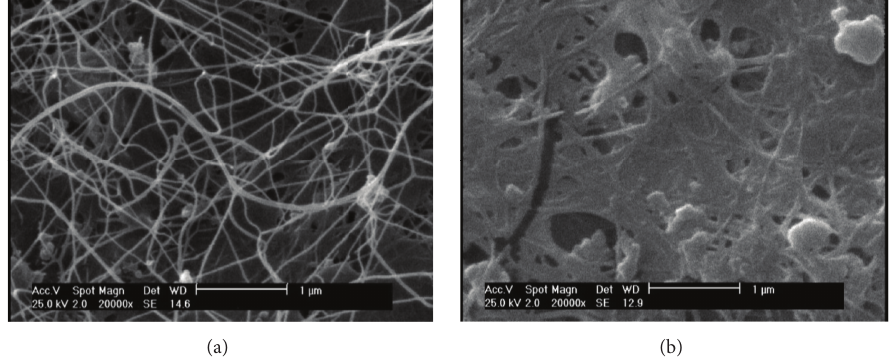
Figure 2: SEM images of (a) free and (b) urease immobilized bacterial cellulose nanofiber.